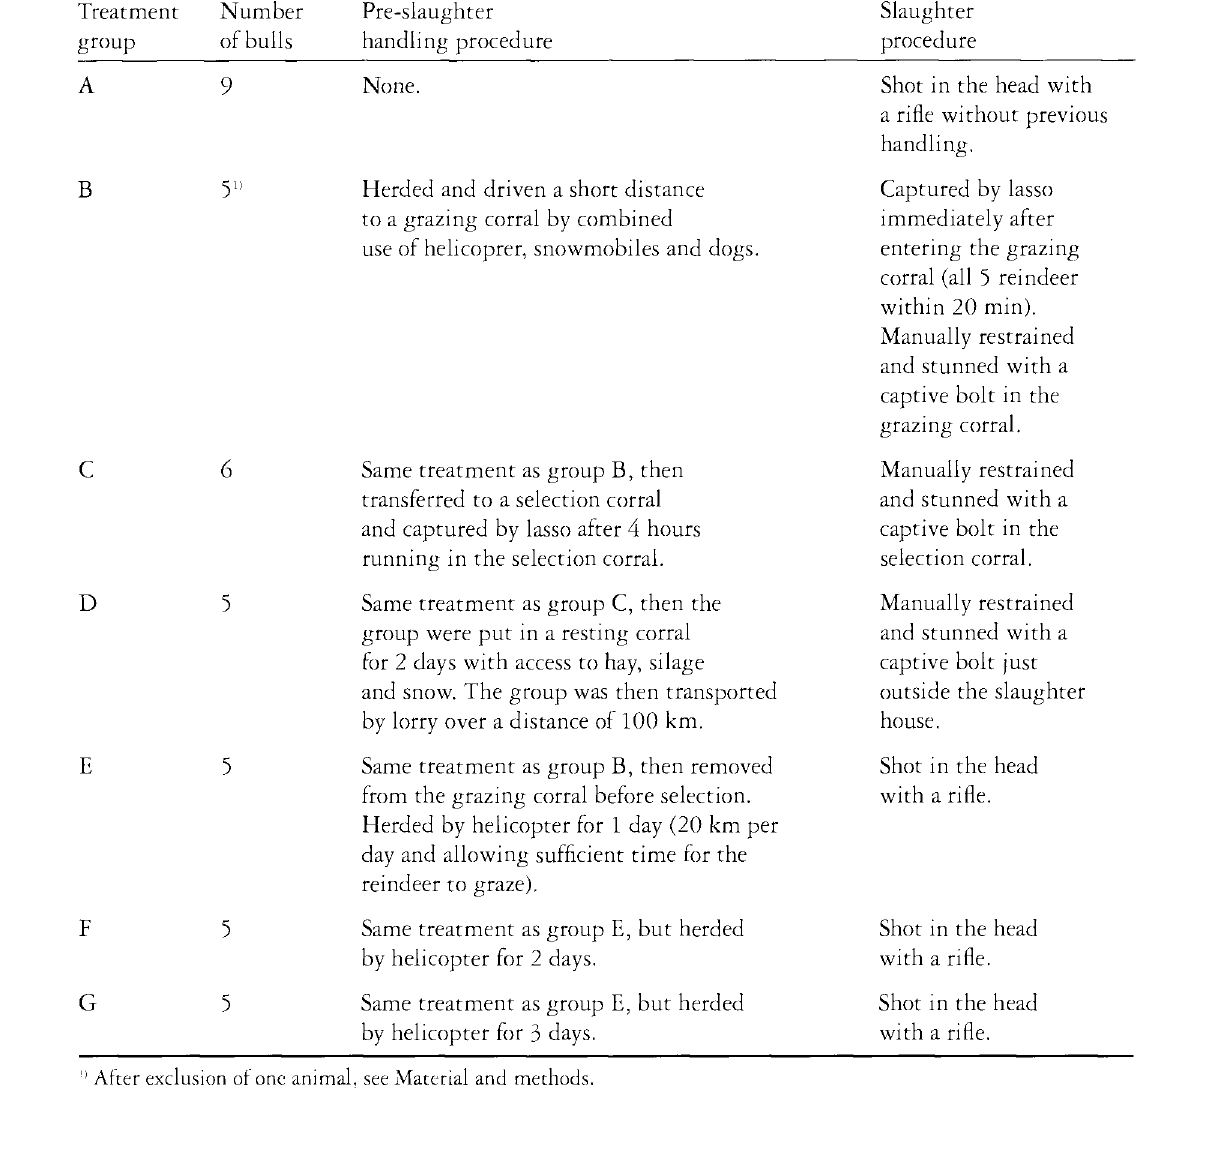
Table 1. Characteristics of various treatment groups of reindeer included in the